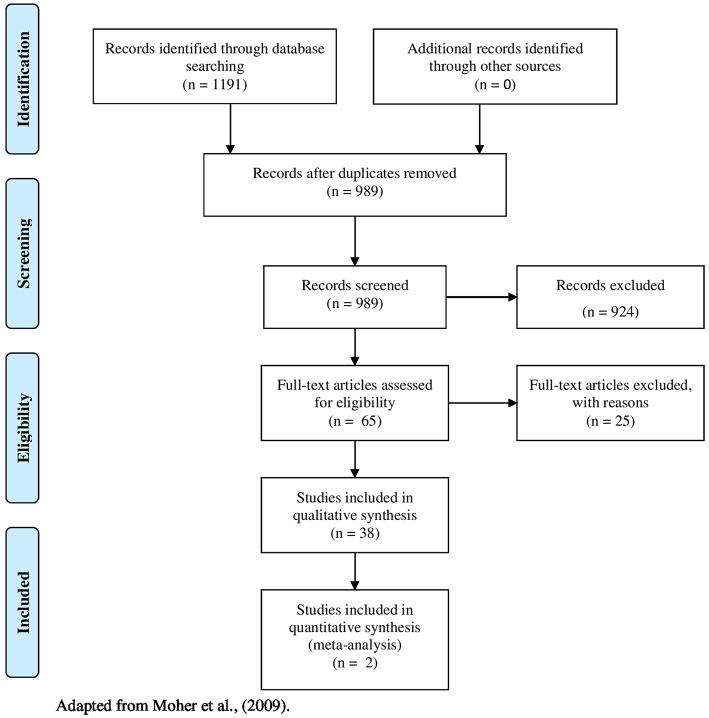
Flow diagram for study selection. Adapted from Moher et al. (2009).